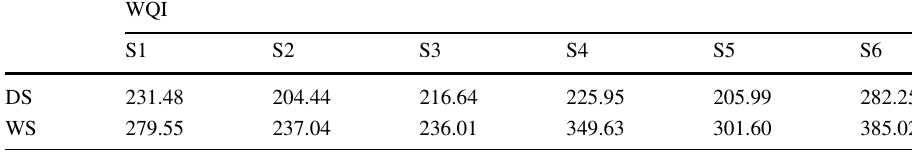
Table 8 WQI values of Shatt